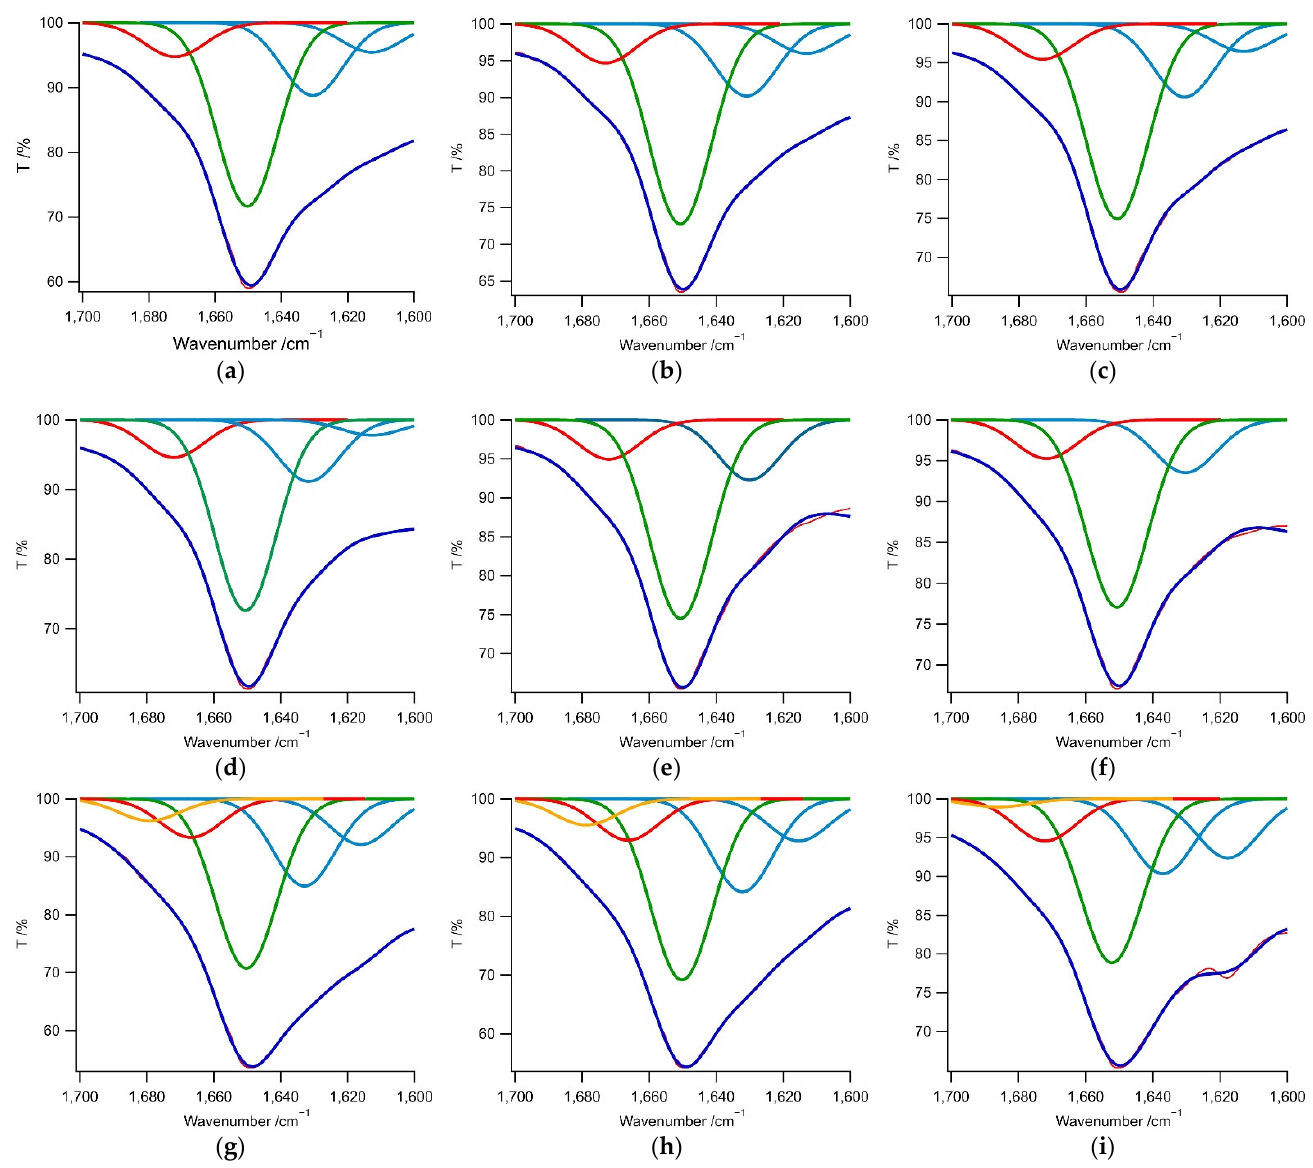
Figure 11. FTIR spectra (purple curves) in the amide I region obtained from the ( a – c ) 1 – 3 /[Au(CN) 2 ] − , ( d – f ) 1 – 3 /[Ag(CN) 2 ] − , and ( g – i ) 1 – 3 /[Pt(CN) 4 ] 2− hybrids, where [Au(CN) 2 ] − = 3.5 mM, [Ag(CN) 2 ] − = 5.0 mM, and [Pt(CN) 4 ] 2− = 2.7 mM. Multiple Gaussian fitting was used to determine the secondary structural components. Blue, green, red, and orange curves denote the amide I features related to β-sheet (1610–1640 cm −1 ), random coil (1640–1660 cm −1 , including P II structures), 3 10 -helix or β-turn-like (1660–1685 cm −1 ), and antiparallel β-sheet structures (1675–1690 cm −1 ), respectively [72–76]. The overall curve fittings are indicated by the red lines. Table 3. Data obtained from amide peaks in FTIR spectra indicating the percentage contributions of